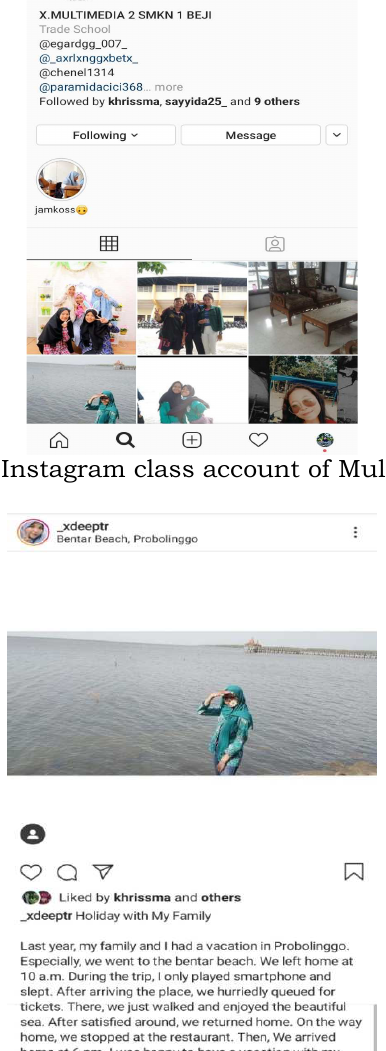
Figure 5. The feedback from the